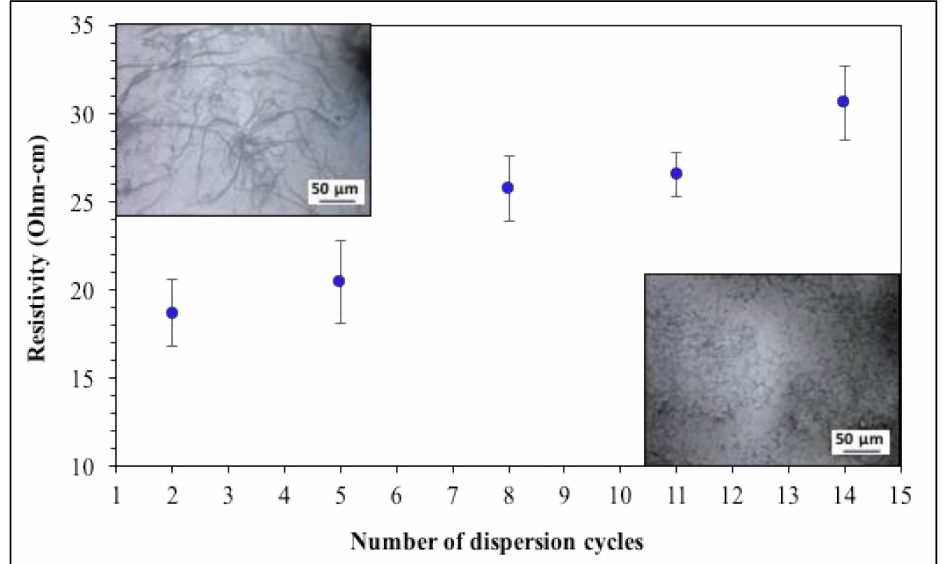
Figure 5. Effect of number of dispersion cycles employed during the fabrication of composites with 0.75% wt CNT on the sample resistivity. The OM inset images correspond to 2 and 14 cycles (left and right respectively). The scale bar represents 50 µ